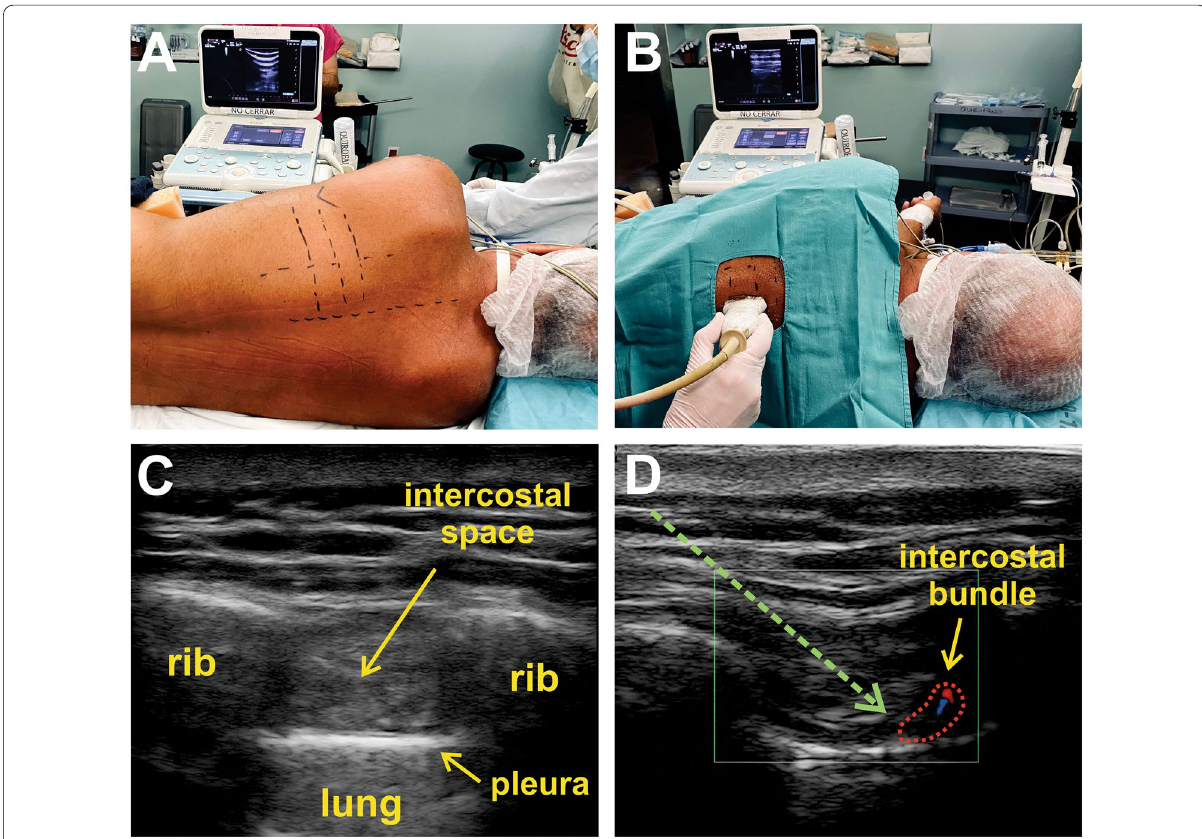
Fig. 1 Patient position and standard US anatomical landmarks. The images belong to a 51-year-old male undergoing left lower lobectomy by u-VATS. A 4th, 5th, and 6th thoracic intercostal spaces are marked. B At those intercostal spaces, an US high-frequency probe is longitudinally placed 7–10 cm parallel to the spine. C Sonoanatomy of intercostal space is easily recognized. D Color Doppler identifies intercostal vessels and nerve. The dotted green arrow depicted the right direction and tip position of the 14G angiocath used during the